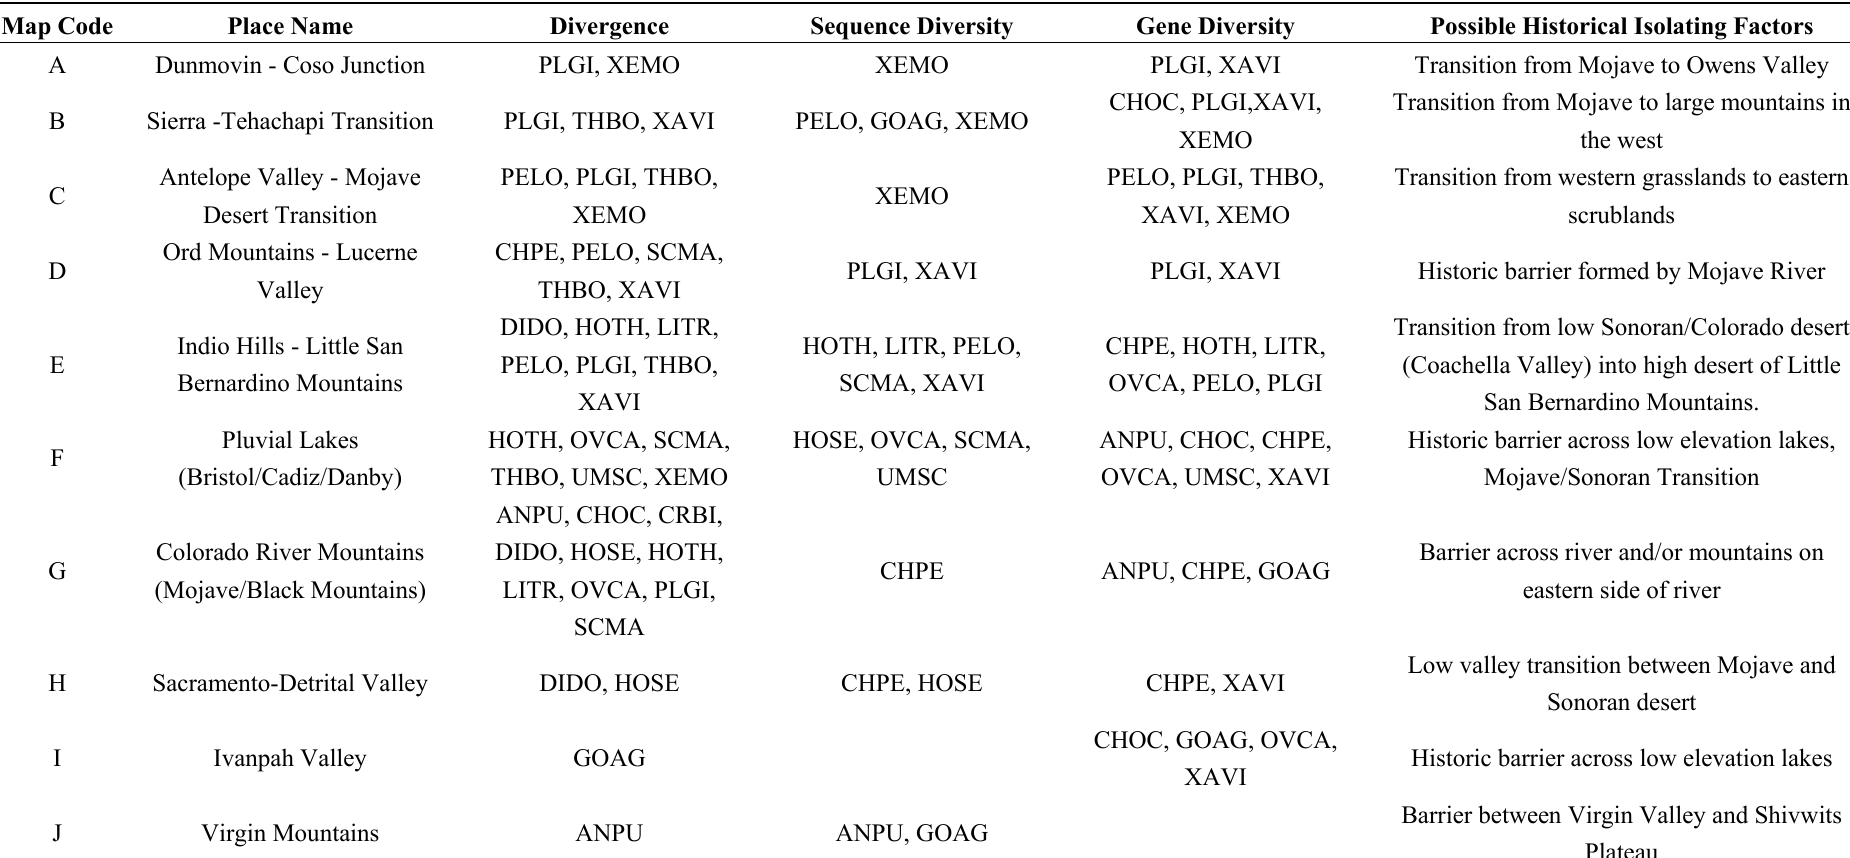
Table 2. Identified divergence and diversity hotspots and individual species contributing to each hotspot. Species codes refer to the first two letters of the genus and species name (full names provided in the table footer). Geographic and geological factors that may have contributed to high levels of genetic divergence and diversity within each region are also